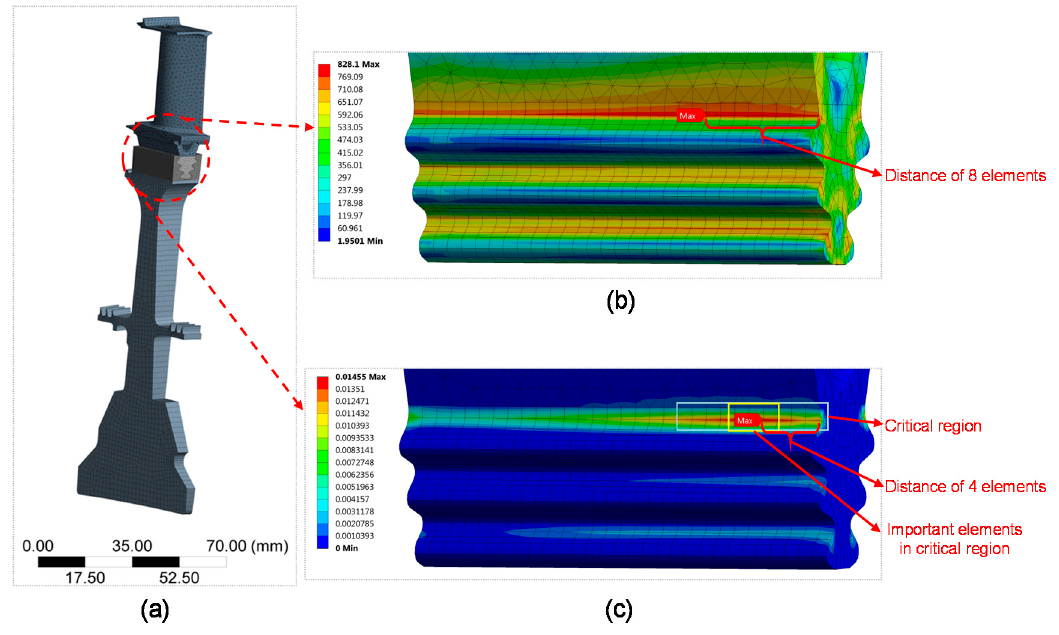
Figure 10. FEA of a turbine disk-blade contact system: ( a ) the mesh; ( b ) von-Mises equivalent stress filed; and ( c ) equivalent plastic strain filed of turbine blade under the 0-Maximum-0 cycle.